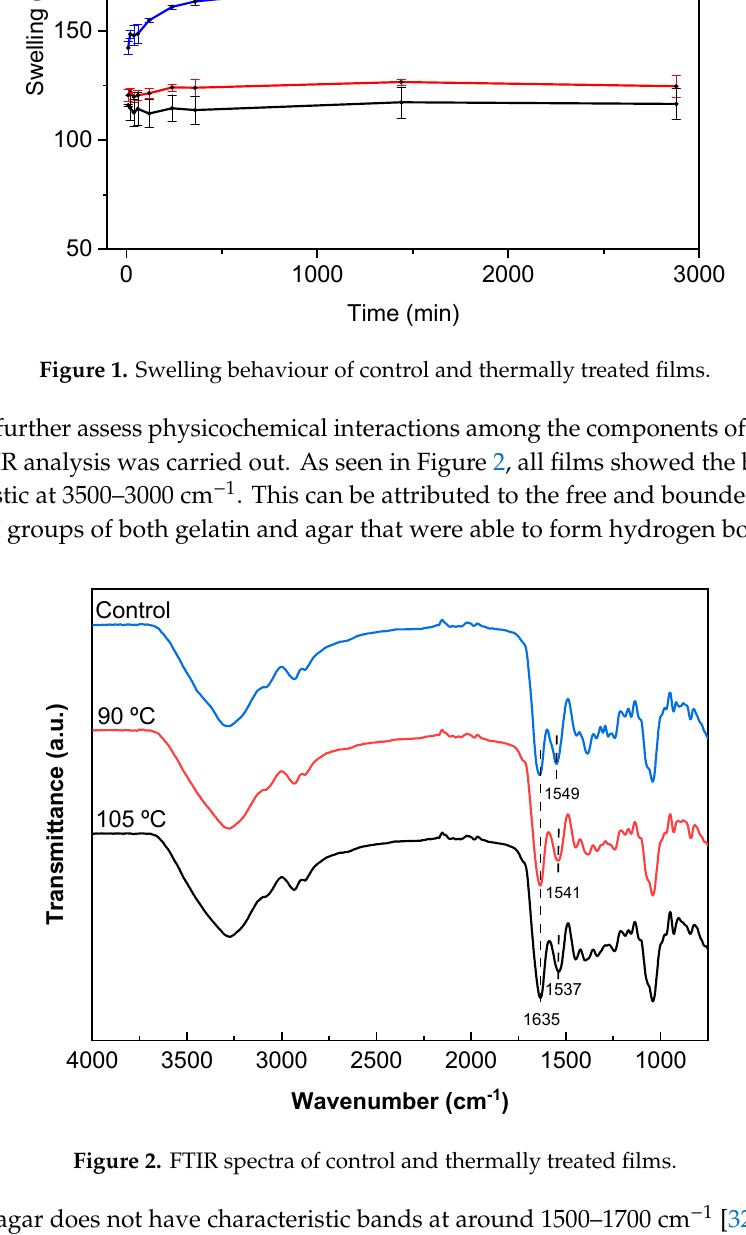
Figure 2. FTIR spectra of control and thermally treated films.